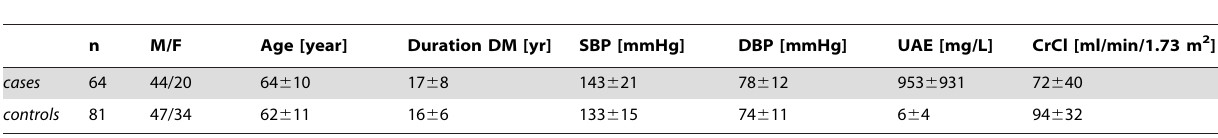
Table 1. Patient characteristics (means 6 SD) of the PREDICTIONS